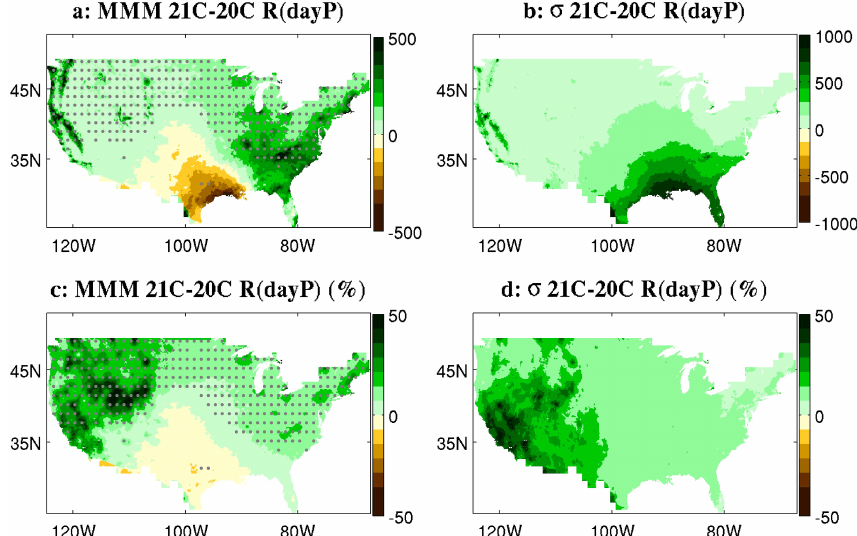
Figure 12. Projections of changes in erosivity: difference between 2079–2099 and 1980–2000, where the future period is simulated under RCP8.5 scenario and the past is from the historical simulation. Erosivity is calculated from daily precipitation values following method 1. (a) Ensemble mean difference in erosivity units (MJmmha − 1 h − 1 year − 1 ). (b) Intra-ensemble standard deviation in erosivity units. (c) En- semble mean difference in percent of mean 20th century values. (d) Intra-ensemble standard deviation in percent.